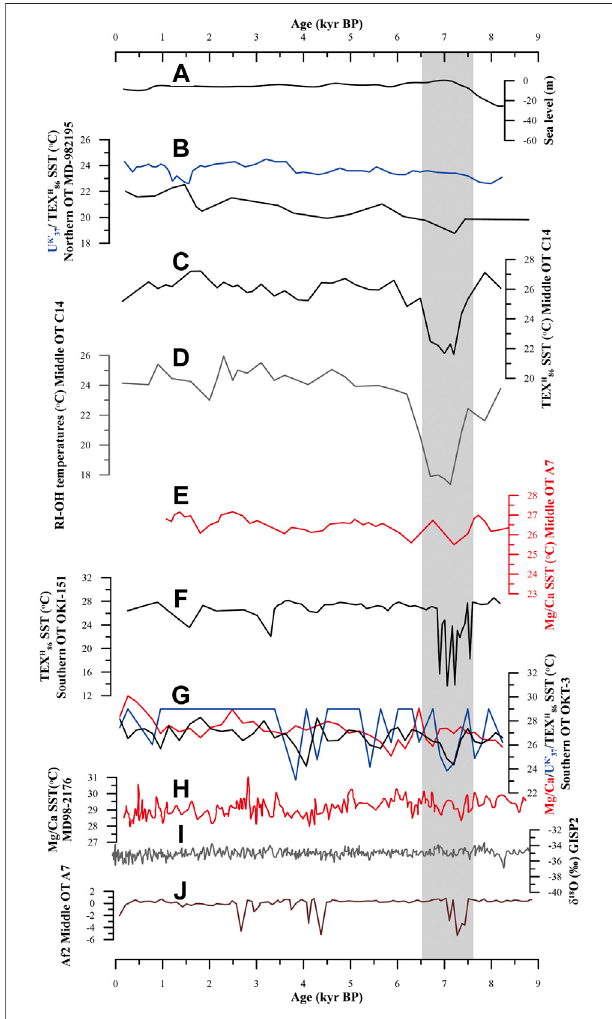
FIGURE 4 | Comparison of paleotemperature variations inferred from coreC14withotherpaleoclimatedata. (A) Postglacialsea-levelchangesinthe western Paci fi c (Liu et al., 2004); (B) Temperatures from U K ’ 37 (blue) and TEX H 86 (dark) in core MD98-2195 (Yamamoto et al., 2013); (C) TEX H 86 SST of C14 in this article; (D) Temperatures from RI-OH in core C14 in this article; (E) Mg/Ca SST of A7 (Sun et al., 2005); (F) SST from TEX H 86 in core OKI-151 (Xu et al., 2018); (G) SST from Mg/Ca (red), U K ’ 37 (blue) and TEX H 86 (black) in core OKT-3 (Zhao et al., 2015); (H) Mg/Ca SST data from core MD98 – 2176 in the western tropical Paci fi c (Stott et al., 2004); (I) δ 18 O record from the GISP2 ice core (Stuiver and Grootes, 2000); (J) the factor representing the western tropical Paci fi c (Stott et al., 2004); (i) δ 18 O record from the GISP2 ice core (Stuiver and Grootes, 2000).